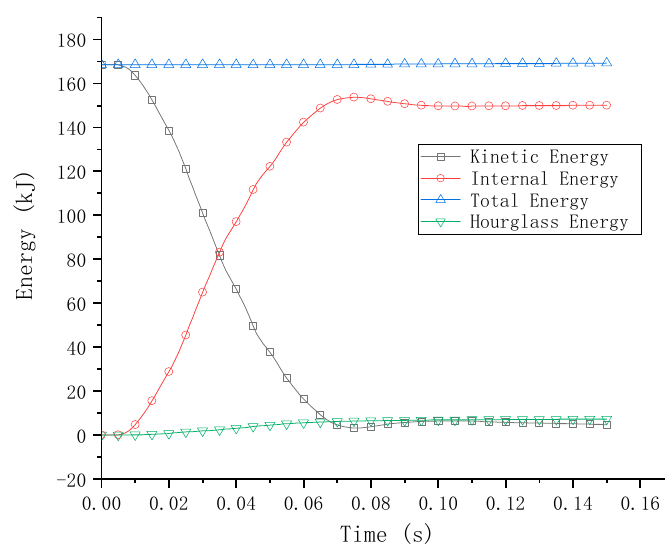
Figure 9. The energy–time curve of a vehicle crashing into a rigid wall.